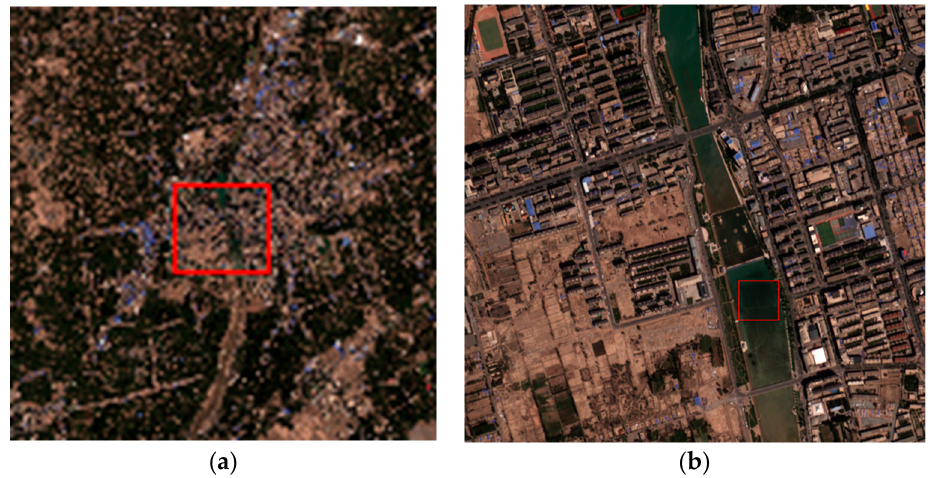
Figure 13. ( a ) Select Water2 area (in the red box) and its surrounding environment (urban background); ( b ) enlarged Water2 area.